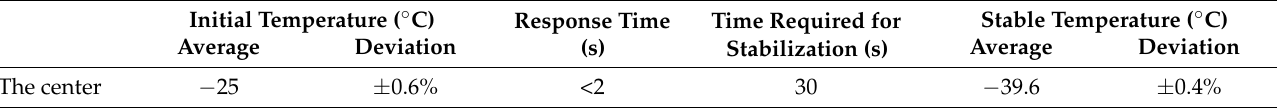
Figure 8. The temperature response curve of the central point at 0.2 Mpa without heating. The experimental data of the temperature at the center point are shown in Table 4. Table 4. Experimental data of three-stage central point temperature without heating and at 0.2 Mpa.